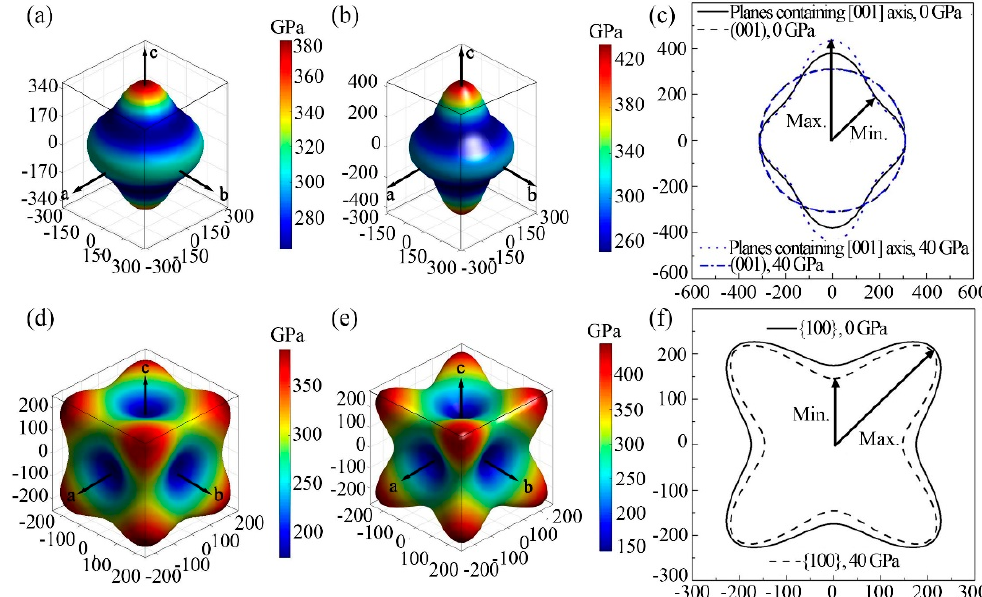
Figure 4. Direction dependences of the elastic moduli of GaN single crystals: ( a ) wurtzite GaN, 0 GPa; ( b ) wurtzite GaN, 40 GPa; ( c ) projections on main crystal planes, wurtzite GaN; ( d ) zinc-blende GaN, 0 GPa; ( e ) zinc-blende GaN, 40 GPa; ( f ) projections on main crystal planes, zinc-blende GaN. Crystals 2018 , 8 , x FOR PEER REVIEW